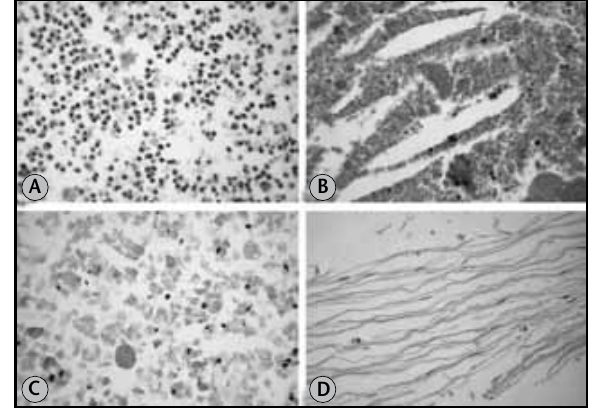
Figura 3 – Análise citológica de material processado pela técnica de cell block ( HE, 400×) (A) Predomínio de leucócitos mononucleados em um caso de cisto radicular; (B) fendas de cristais de colesterol associadas à grande quantidade de hemácias íntegras e fragmentadas em um caso de cisto residual; (C) discreta presença de células inflamatórias e material amorfo em um caso de cisto dentígero; (D) fitas de paraceratina em um caso de